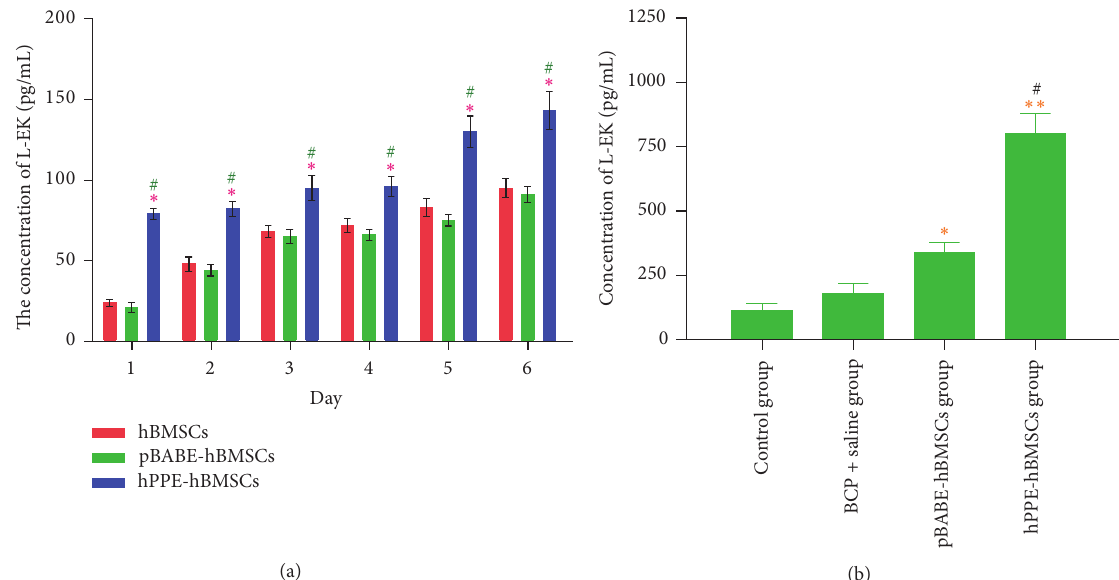
Figure 3: Production of Leu-encephalin (L-EK) by hBMSCs, pBABE-hBMSCs, and hPPE-hBMSCs was measured for 6 days after gene transfection in vitro (a) and in vivo (b) . pBABE, a retroviral vector; hPPE, human proenkephalin; pBABE-hBMSCs, the pBABE-hBMSCs group; hPPE-hBMSCs, the hPPE-hBMSCs group; BCP, bone cancer pain; hPPE, human proenkephalin. In (a), from day 1 to day 6, L-EK levels in hPPE gene engineered hBMSCs group were increasing and significantly higher compared with those in the other two groups. The transfection of hPPE accelerated L-EK secretion from hBMSCs. ∗ 𝑃 < 0.05 versus hBMSCs group, # 𝑃 < 0.05 versus pBABE-hBMSCs group. In (b), Leu-encephalin (L-EK) expression was significantly upregulated in human bone marrow stem cells (hBMSCs) transfected with hPPE group and the concentration was higher compared with that in pBABE-hBMSCs ( 𝑃 < 0.01 ) and control ( 𝑃 < 0.05 ) groups. The pBABE- hBMSCs group showed a higher concentration than control group ( 𝑃 < 0.05 ). ∗ 𝑃 < 0.05 versus control group; ∗∗ 𝑃 < 0.01 versus control group; # 𝑃 < 0.01 versus pBABE-hBMSCs group. 𝑛 = 6